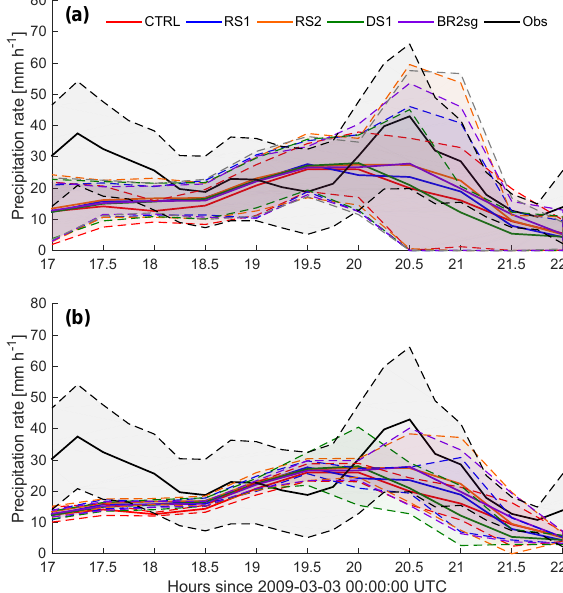
Figure 9. Time series of precipitation rate, both from the UK NIM- ROD rain radar in black and from various simulations in color for a small domain around CFARR from 17:00 to 22:00UTC. For all traces, the mean is shown with an envelope of plus–minus a standard deviation for the observations and the first and third quantile for the simulations. (a) The quantiles are calculated over the small spatial domain, and in panel (b) , they are calculated over the 5-member